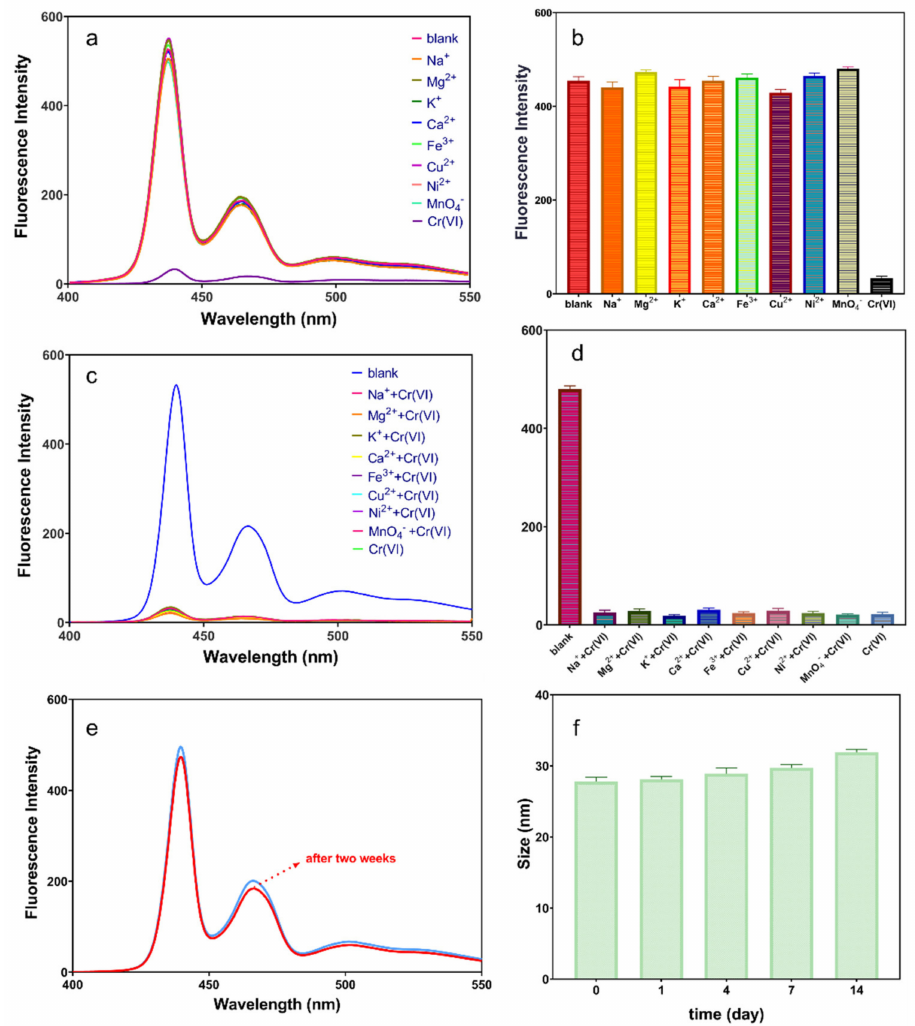
Figure 3. Fluorescence spectra of PFO-DPC with various metal ions in the absence ( a ) and presence ( c ) of Cr (VI) ion. Fluorescence response of PFO-DPC (emission 440 nm) with various metal ions in the absence ( b ) and presence ( d ) of Cr (VI) ion. The fluorescent stability of PFO-DPC ( e ). The structural stability of PFO-DPC ( f